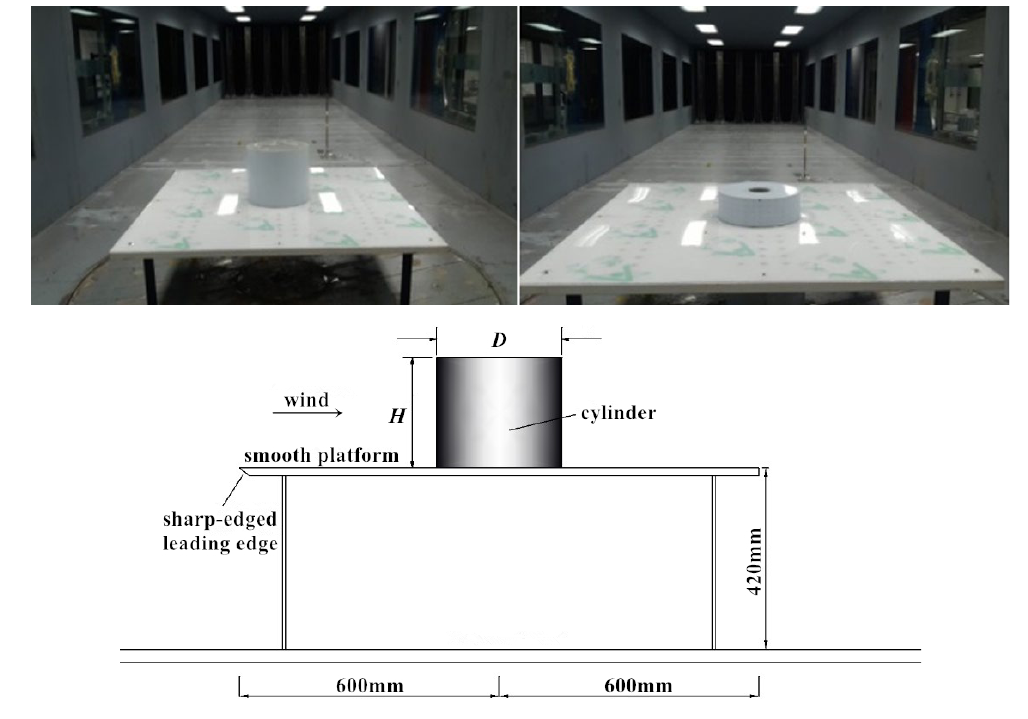
Figure 2. Experiment setup in the wind tunnel.